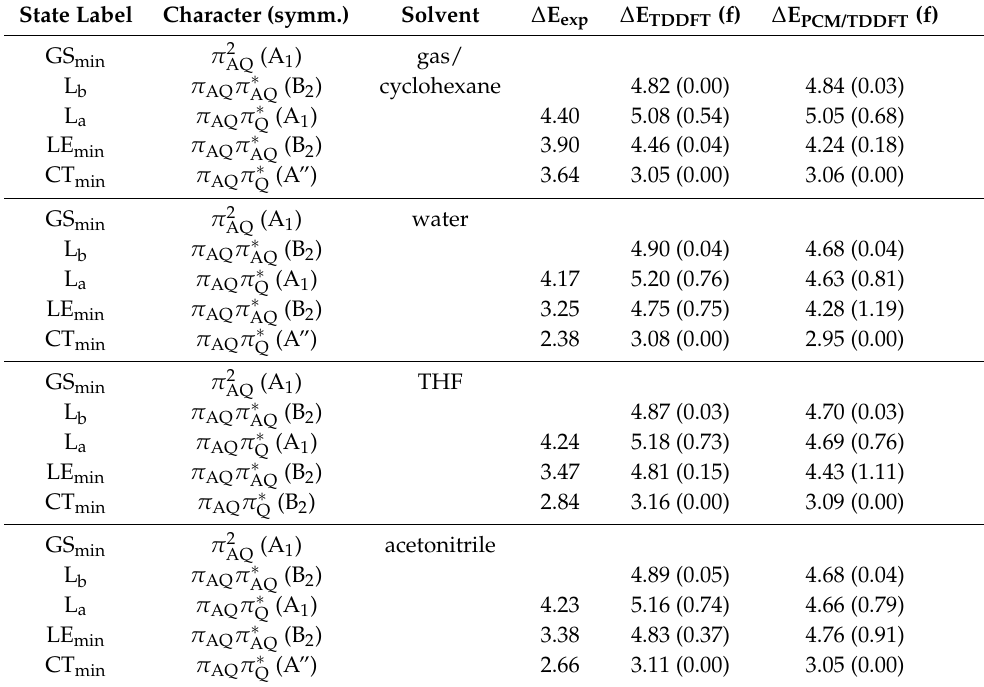
Table 2. Table showing electronic state character and vertical energies in electronvolts relative to the ground state of the most relevant points of the potential energy surfaces of DMABN in the gas phase and the micro-solvated cluster of DMABN and two water molecules, two tetrahydrofuran molecules and two acetonitrile molecules. The symmetry irreducible representations belong to the C 2 v group in the case of GS min , L b , L a and LE min and to C s in case of CT min . ∆ E exp is the experimental energy measured in this work, ∆ E TDDFT is the TDA-wB97X-D3/cc-pVDZ calculated energy of the gas phase molecule or the solvent clusters, ∆ E PCM/TDDFT is the TDA-wB97X-D3/pt(SS+LR)-CPCM/cc-pVDZ calculated energy of the gas phase molecule or the solvent clusters in a solvent continuum model and f is the oscillator strength of the transition to that state from the ground state. State Label Character